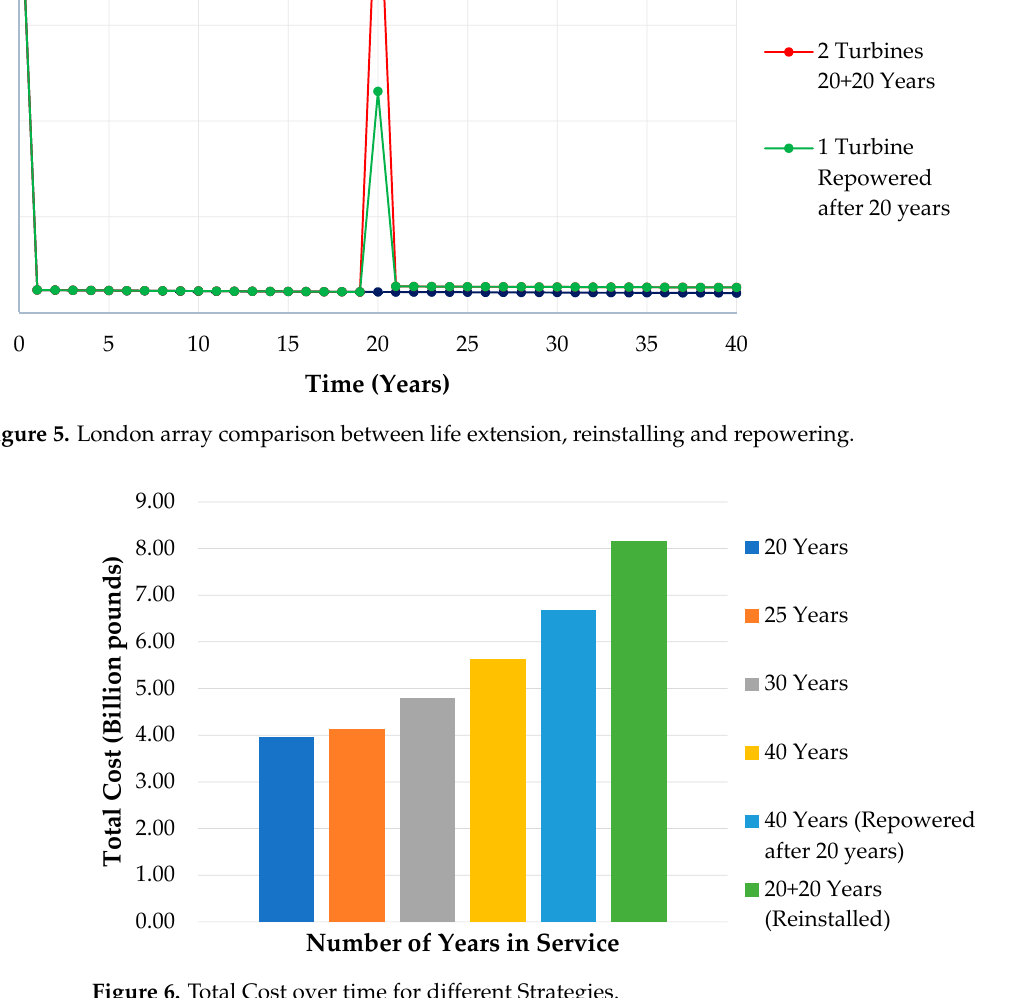
Figure 6. Total Cost over time for different Strategies.